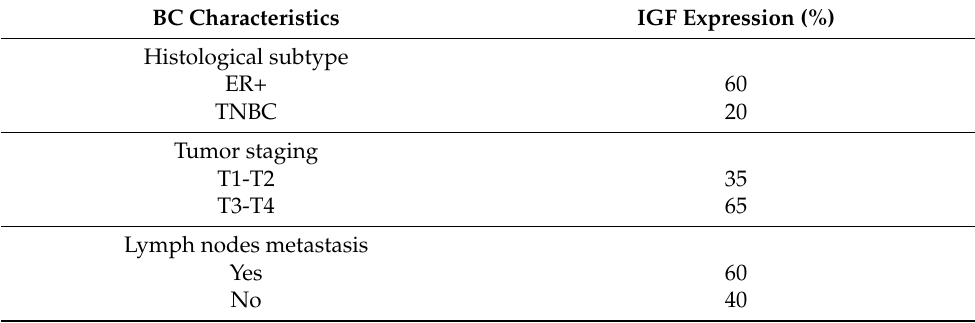
Table 1. Insulin-like growth factor (IGF) expression (%) according to breast cancer (BC) patients’ characteristics: A higher expression is observed in patients with worse prognostic